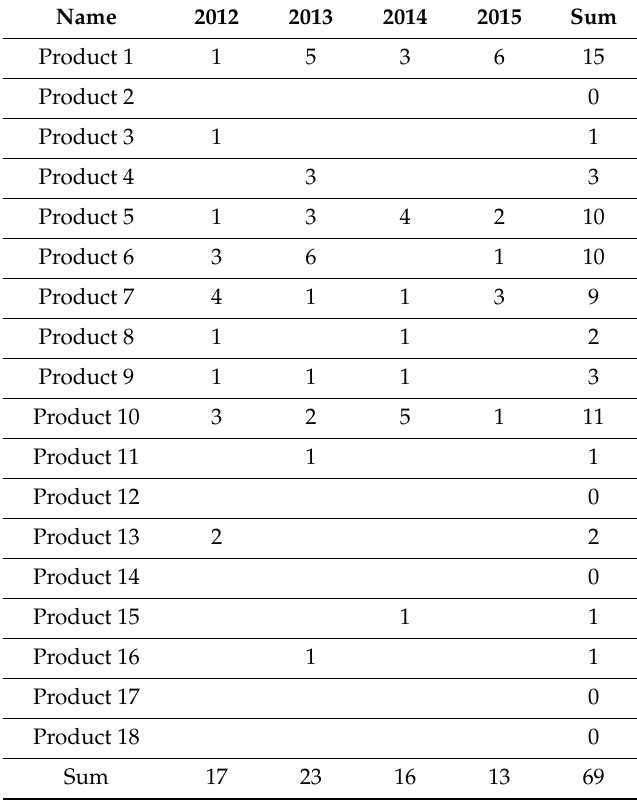
Table 1. Quantities of the products produced in the period